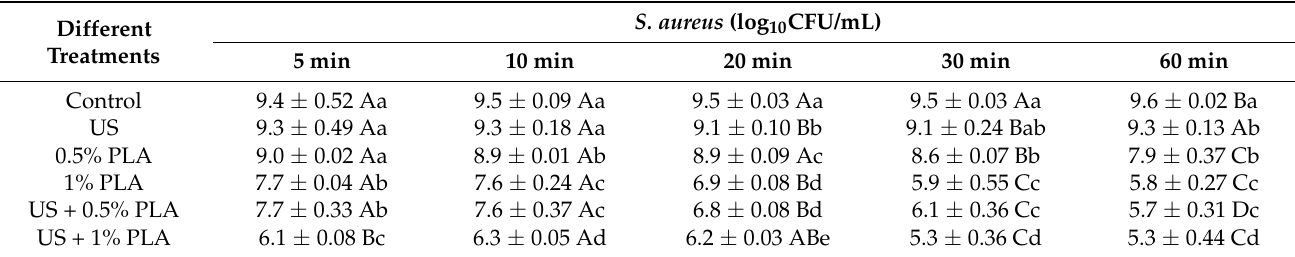
Table 1. Residual bacterial counts in S. aureus biofilms cells after the different treatments. Different Treatments